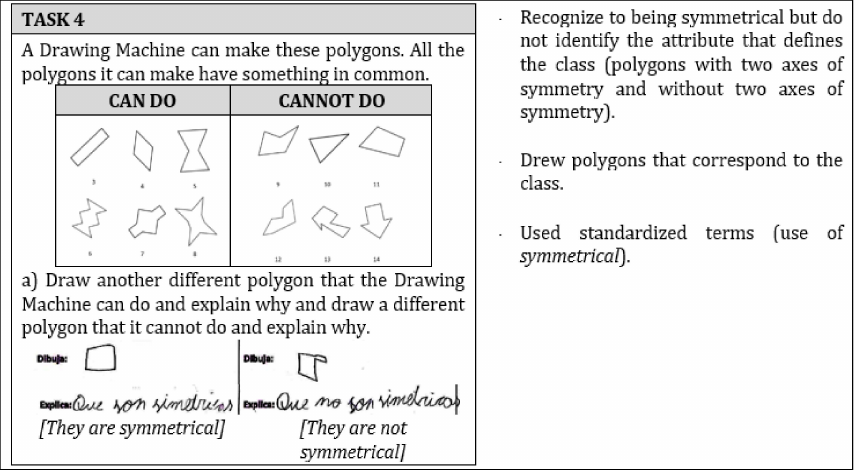
Figure 8. Memo of the answer of student G2S18 when performing the task of identifying the attribute that defines a class and representing an example and a non-example of the class (middle